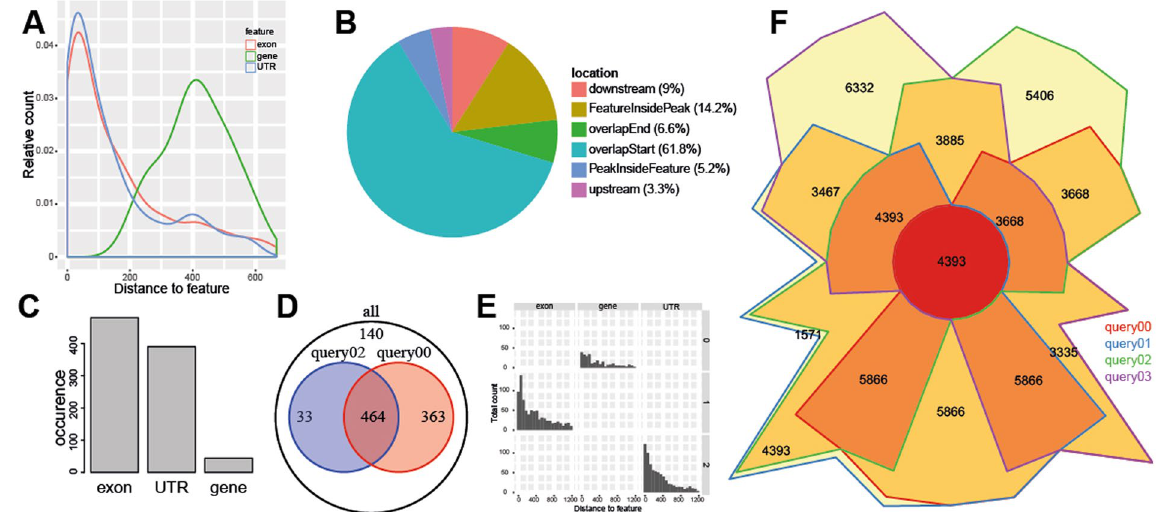
Figure 3. UROPA graphical summary report. ( A ) The distance to the feature anchor is displayed as a fraction of the total peaks annotated using a density plot. This information can be useful to determine optimal distance settings for annotation. ( B ) Relative localization of peaks in relation to the annotated feature (one pie chart plot per feature). ( C ) Bar plot of total occurrence of individual features (one plot per query). ( D ) All queries are included in a pairwise comparison to show possible overlaps. Assuming multiple concurrent queries, the amount of exclusively and commonly annotated peaks can be deduced. ( E ) Distance histogram in relation to query and feature where each query is depicted separately. ( F ) The Chow Ruskey plot represents an area- proportional Venn diagram. It reveals the distribution of peaks that could be annotated per query and works for up to 5